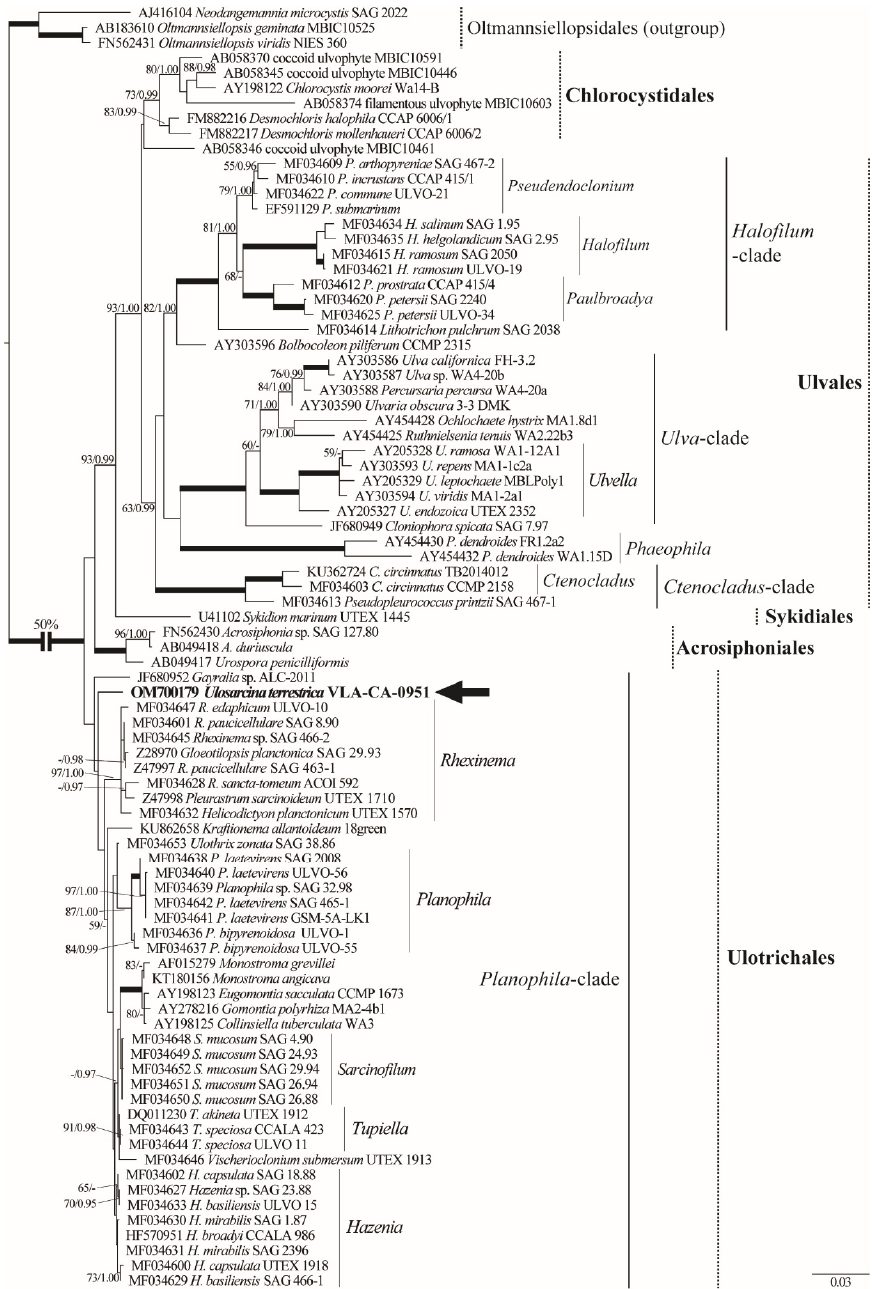
Figure 2. ML phylogenetic tree (TIM2+I+G model) of the Ulvophyceae showing position of the new genus Ulosarcina (showed boldface with arrow) based on SSU rDNA sequence data (1771 aligned positions of 86 sequences). The strain designations and GenBank accession numbers of all sequences used in the analyses are given. Support [(BP) ≥ 50% and (PP) ≥ 0.95: ML/BI] are provided above/below the branches. Branches with 100% BP and 1.00 PP are shown in boldface. Clade designations follow Darienko and Pröschold [4] and Darienko et al. [5].